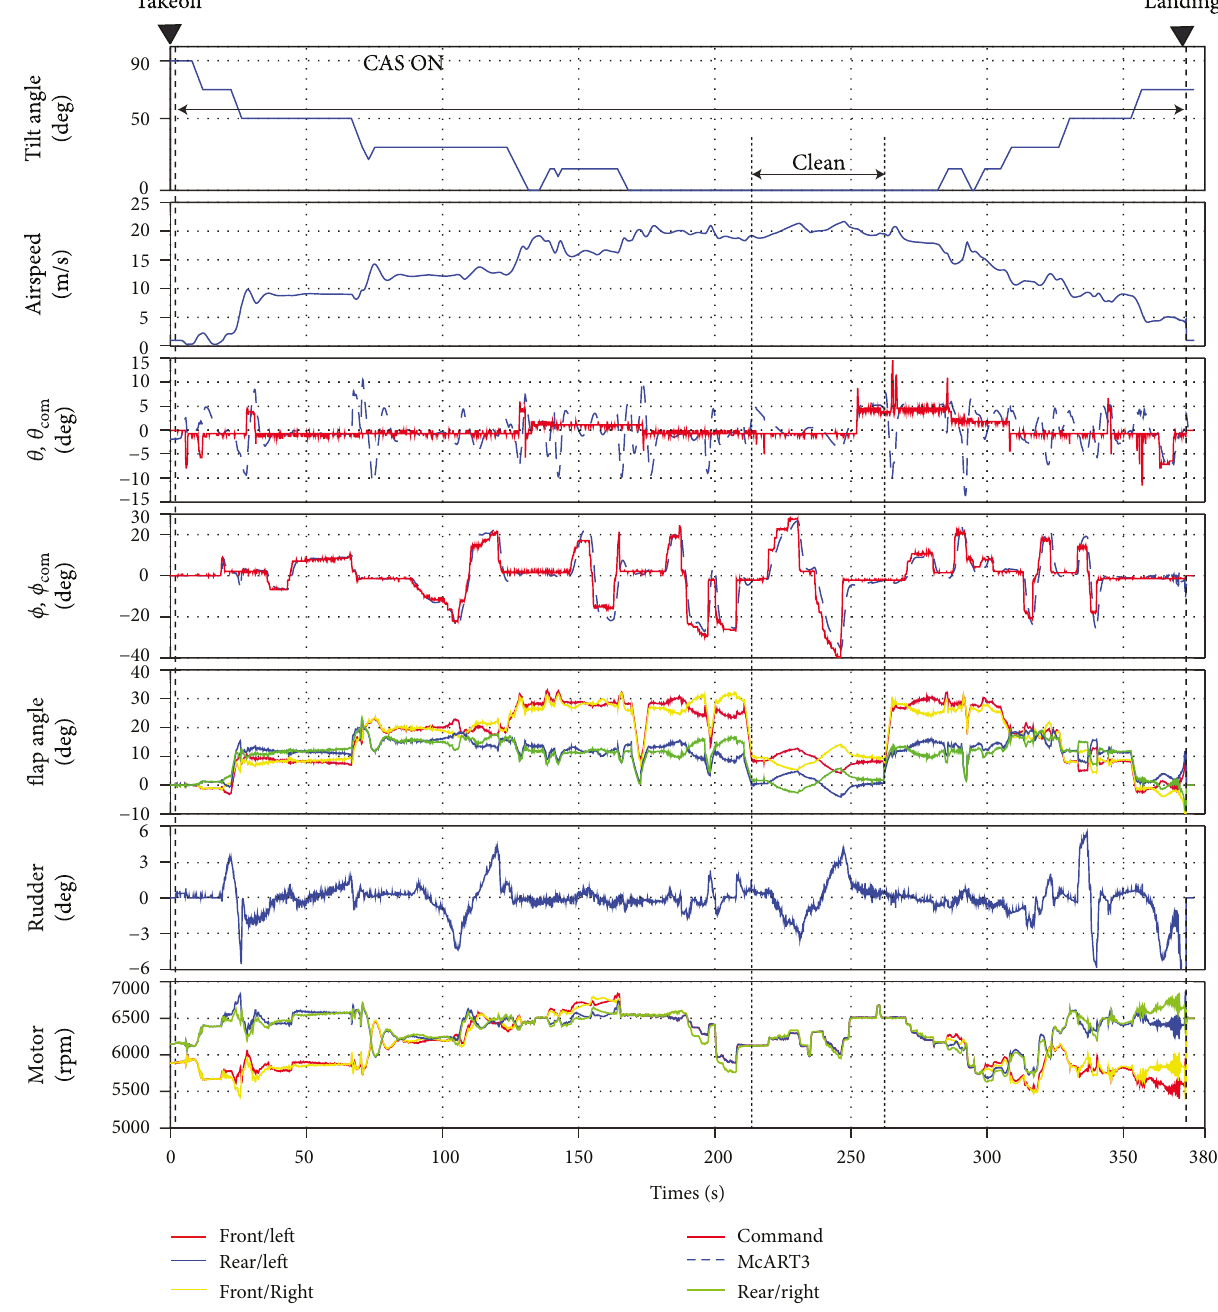
Figure 10: Time history of human-in-the-loop fl ight simulation without wind